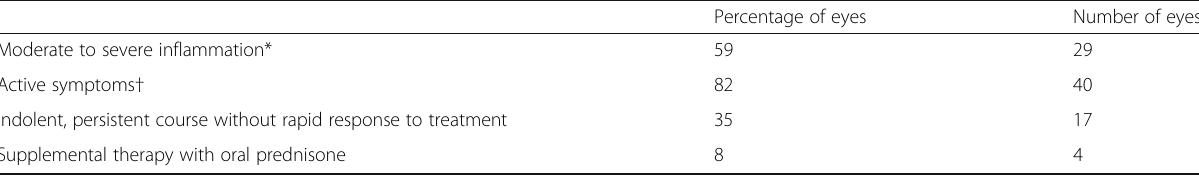
Table 5 Post-operative symptomatology, exam findings, and treatment course in the prolonged iritis group